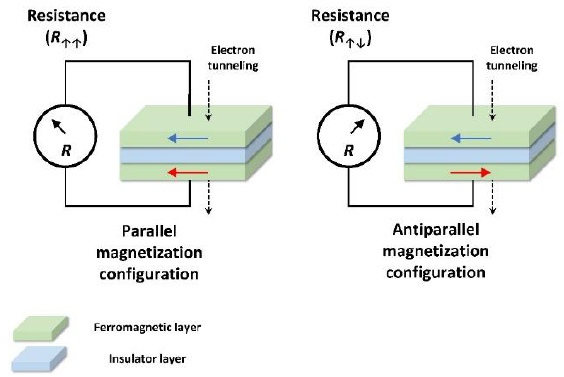
Figure 3. Schematic diagram of tunneling magnetoresistance (TMR).